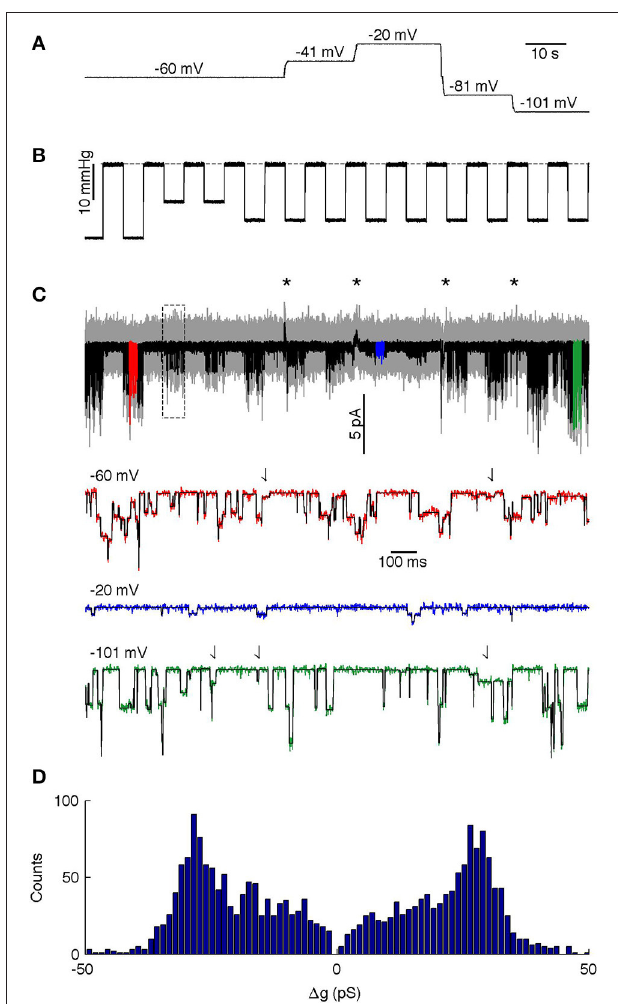
FIGURE 6 | Analysis of PIEZO1 channels. (A) Membrane potential during the recording. (B) Mechanical stimulus, dashed line indicates 0 mmHg. (C) Analyzed current trace. Gray is unfiltered raw data; black is low-pass filtered data. Black asterisks indicate capacity artifacts during changes in membrane potential; the rectangle indicates the region analyzed in Figure 8 . Colored segments (red, blue, and green) are shown in detail below with the idealized trace in black. Arrows in highlighted traces (red and green only) indicate putative sub-state currents. (D) Histogram of channel events.